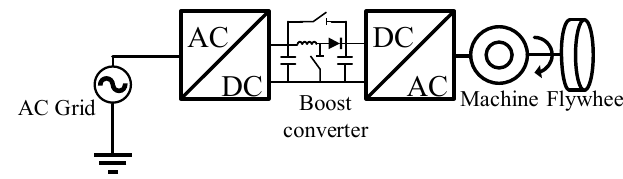
Figure 24. Indirect AC converters with the boost converter.